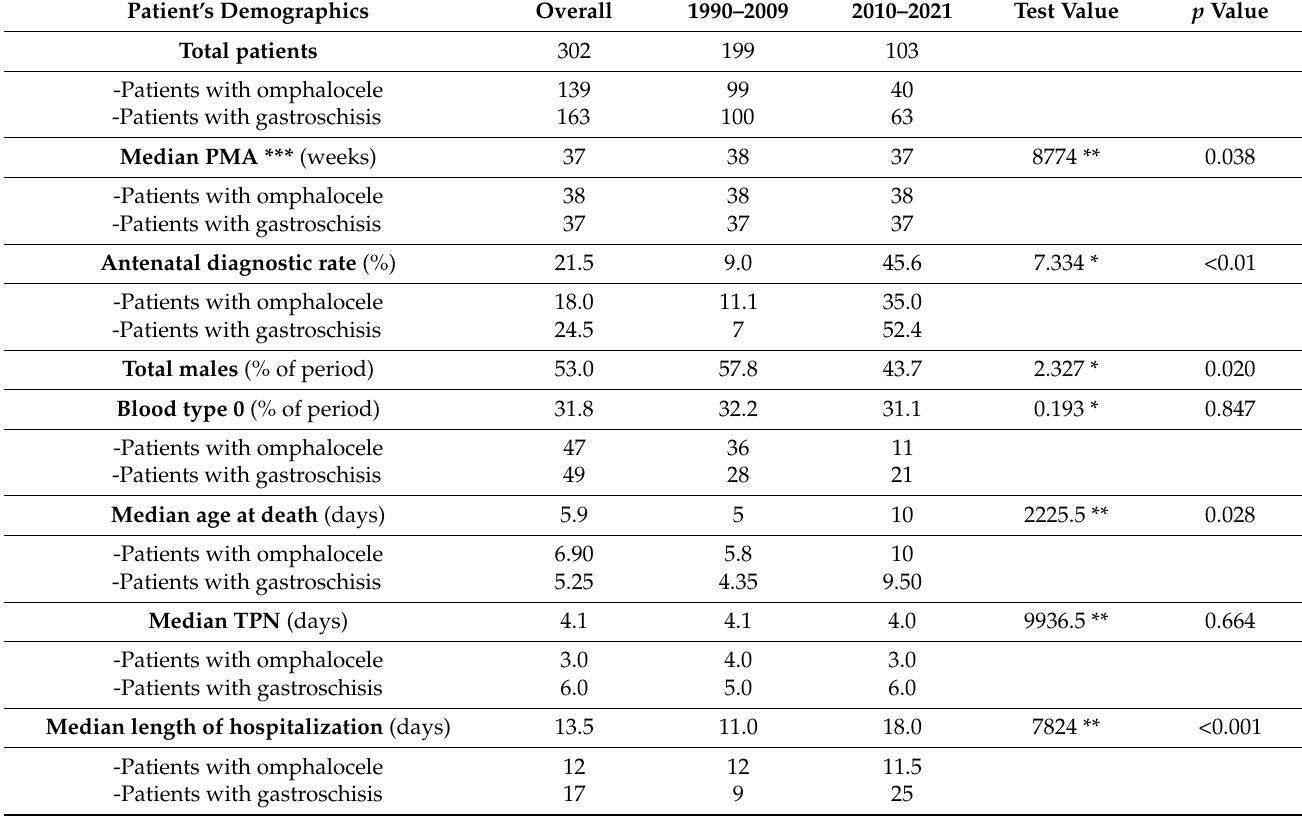
Table 1. Patient characteristics in the two analyzed